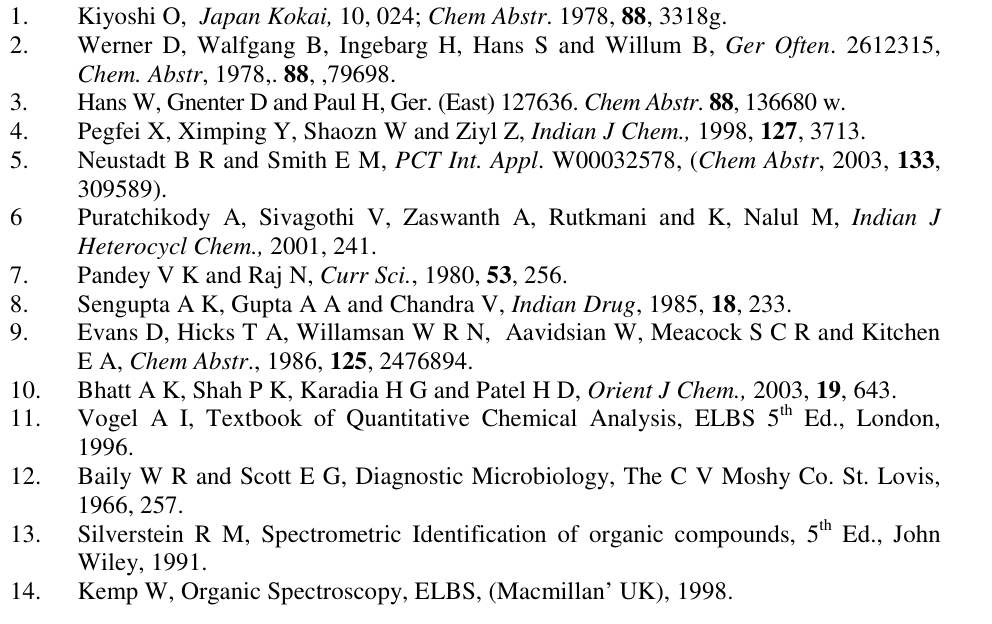
Table 3. Antifungal activity of ligand HL